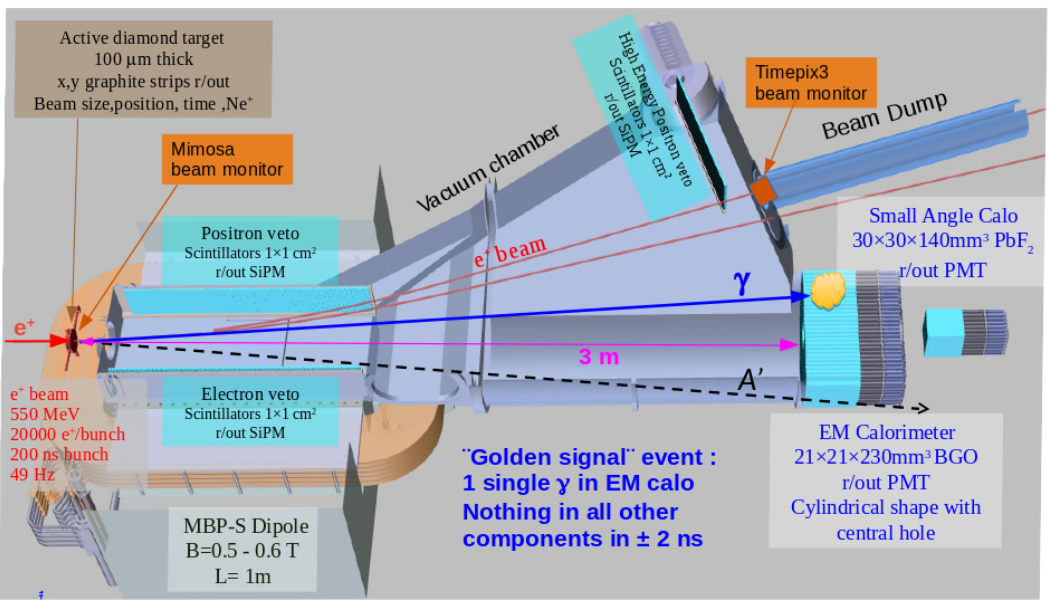
Figure 2. Padme detector 3D layout with all basic components explained. In the figurem we show also a “Golden” event in the